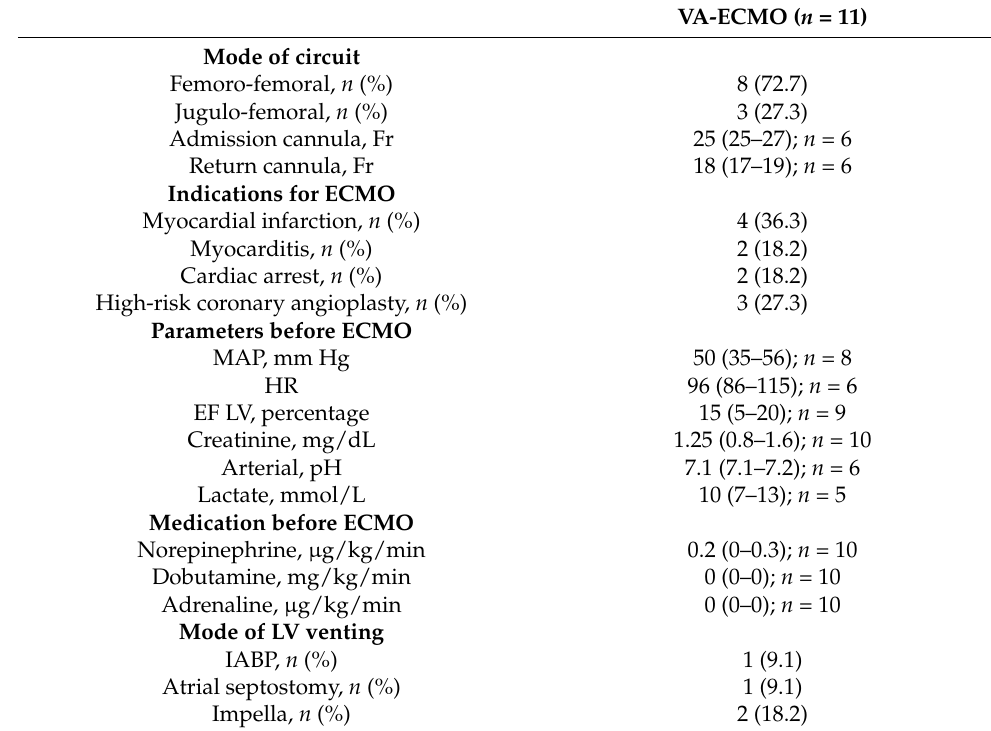
Table 3. Patient characteristics on